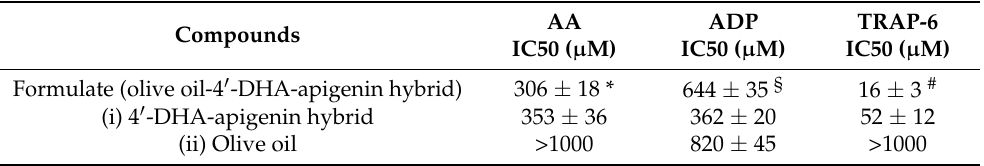
Table 2. IC50 values of the inhibitory effect of 4 (cid:48) -DHA-apigenin hybrid/olive oil formulation, 4 (cid:48) - DHA-apigenin hybrid and olive oil, on AA, ADP and TRAP-6-induced platelet aggregation. AA ADP TRAP-6 Compounds IC50 ( µ M) IC50 ( µ M) IC50 ( µ M) Formulate (olive oil-4 (cid:48) -DHA-apigenin hybrid) 306 ± 18 * 644 ± 35 § 16 ± 3 #